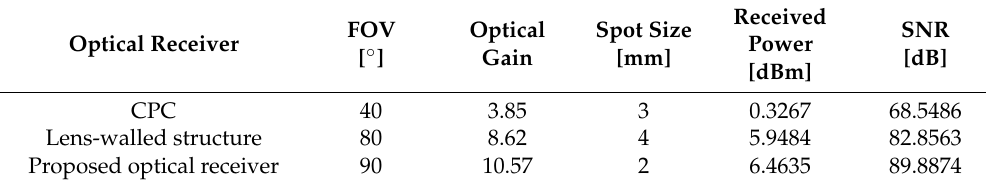
Table 13. Comparison results of three different design methods.